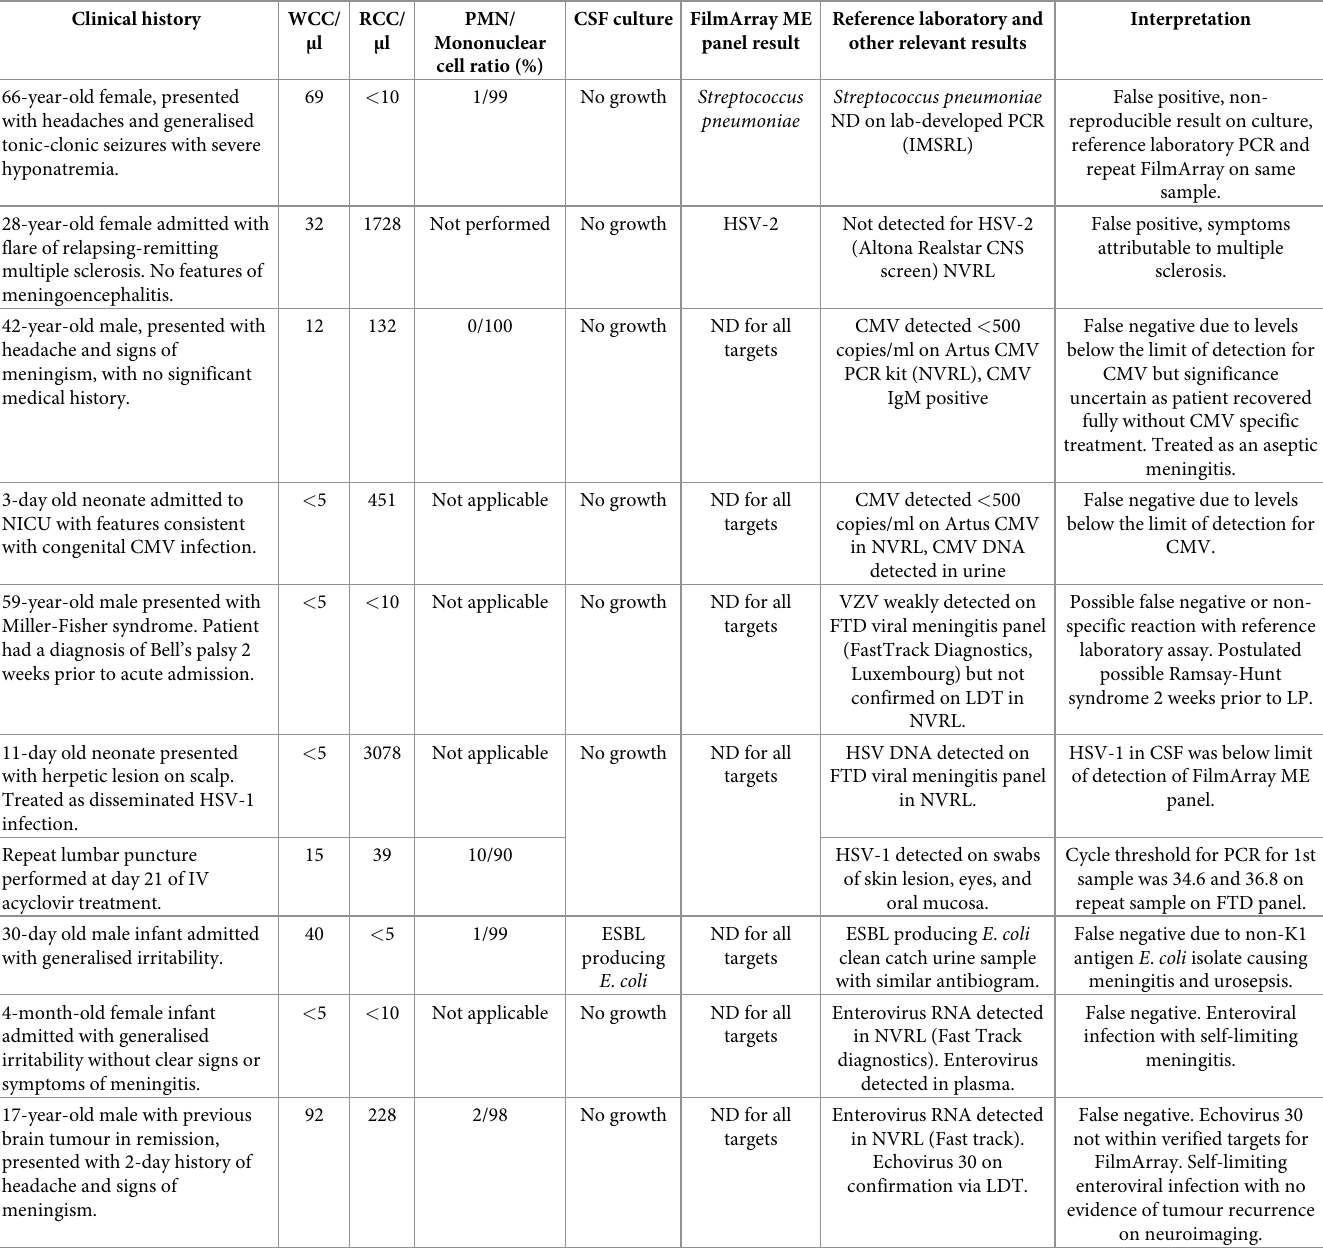
Table 2. False positive and negative results: Clinical history, laboratory results and